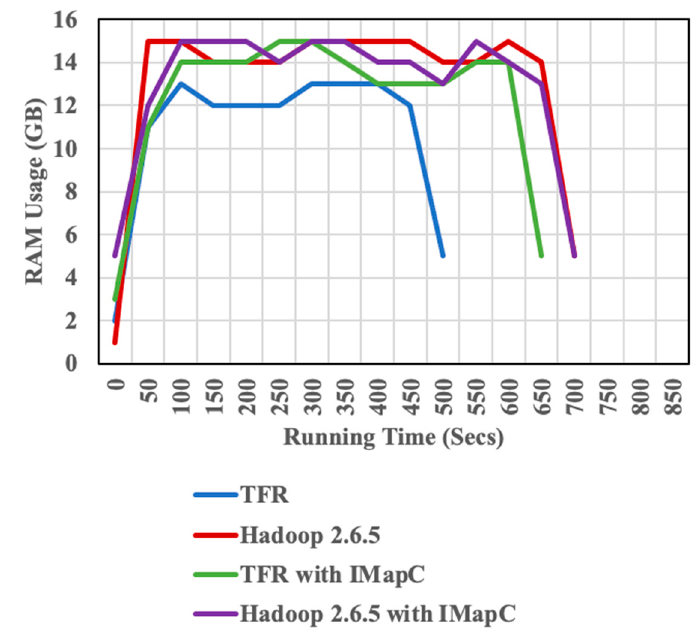
Figure 12. Memory usage on running WordCount job.